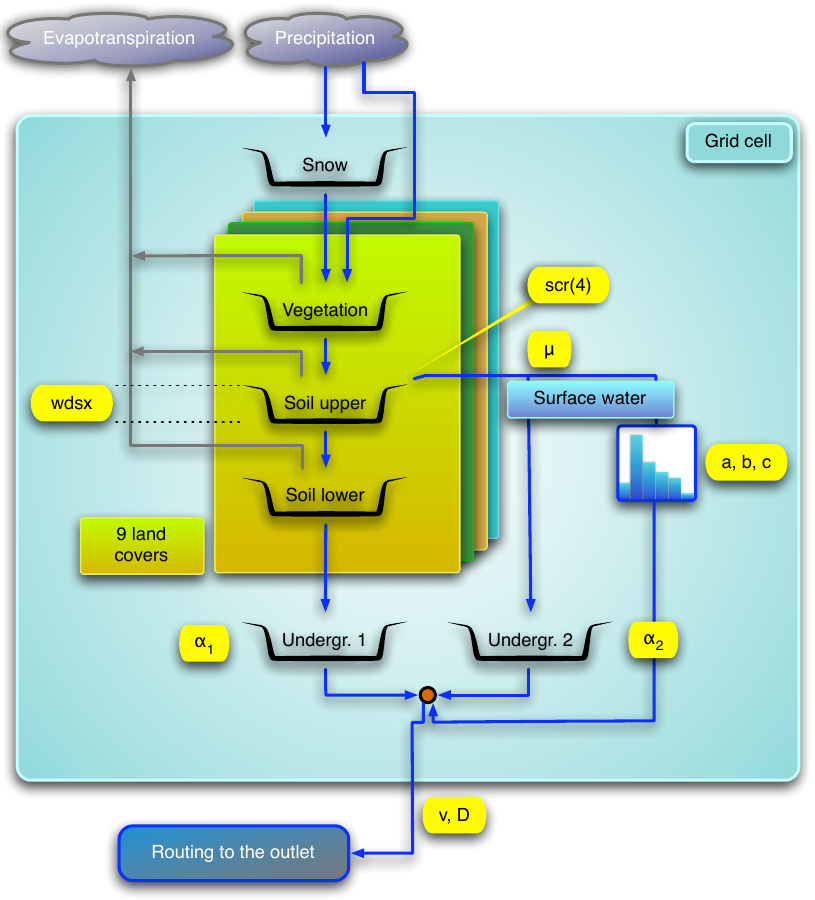
Figure 3. Diagram of processes of the SCHEME model. Model parameters: (1) wdsx , threshold value for upper soil reservoir; (2) scr ( 4 ) , seasonal runoff coefficients; (3) µ , redirection coefficient for surface flow; (4) a, b and c, parameters describing a unit hydrograph; (5) α 1 and α 2 , recession coefficients of the underground reservoirs; (6) v and D, routing module